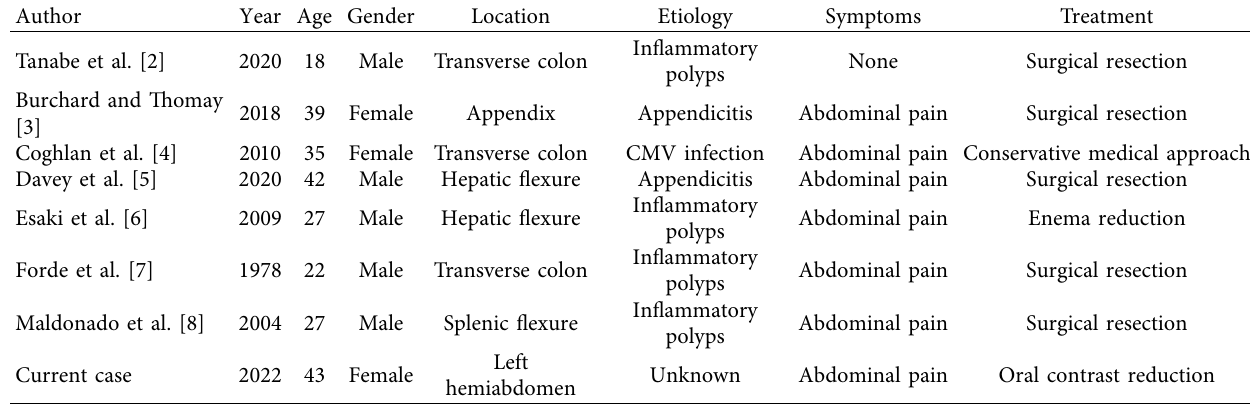
Table adapted from Tanabe et al.